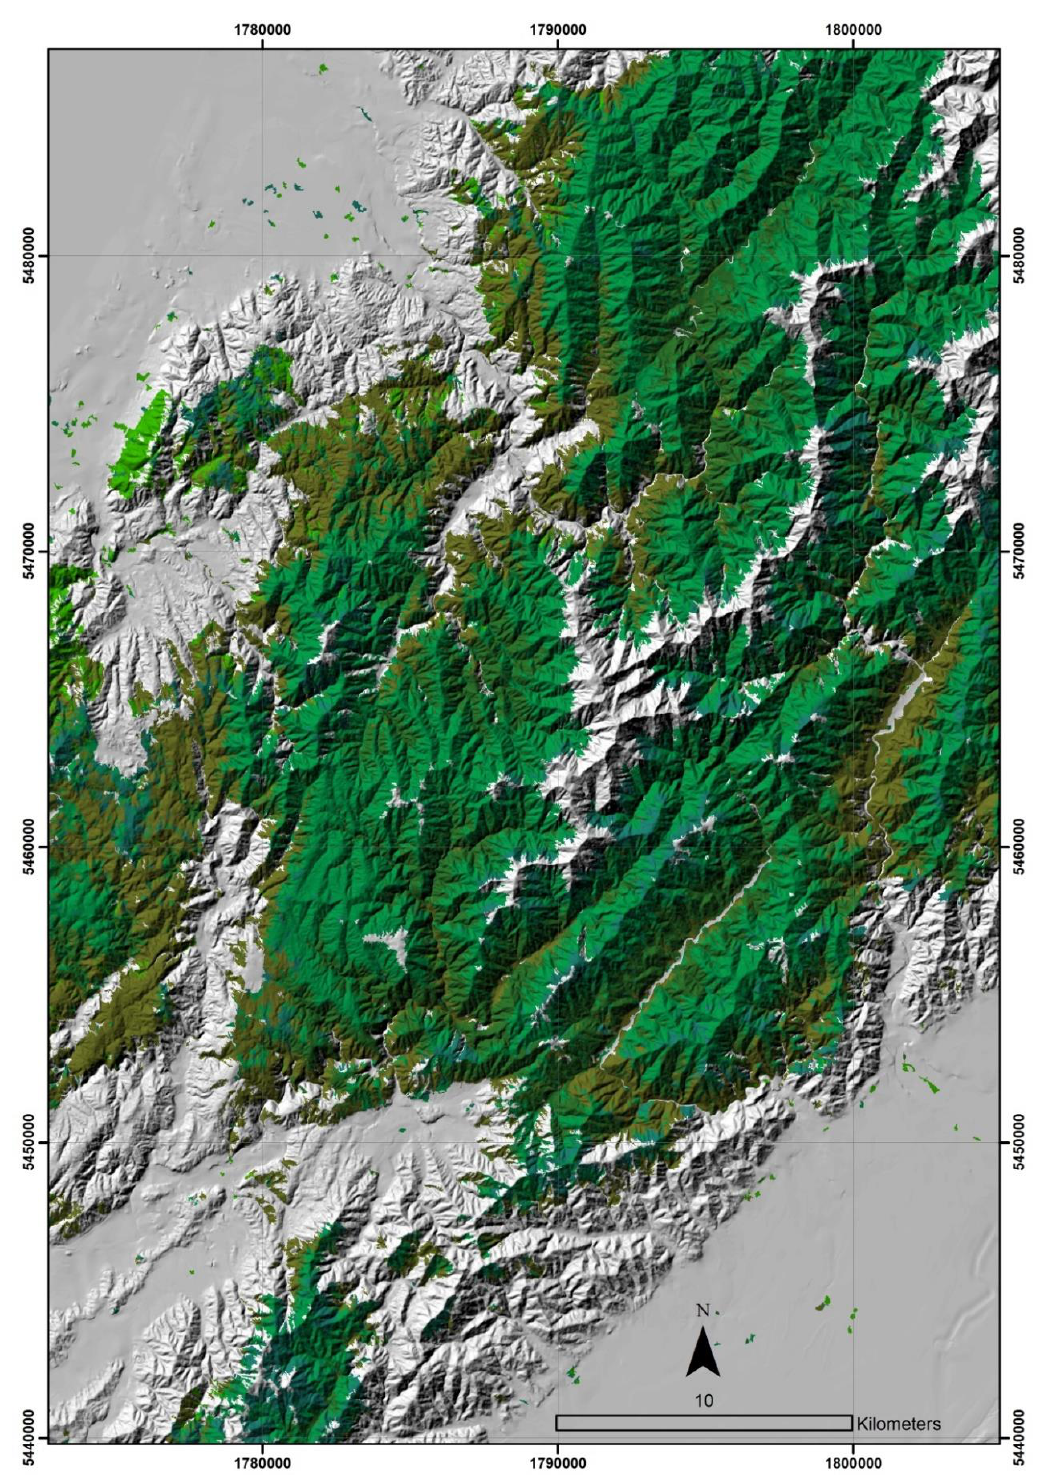
Figure 2. Map of forest physiognomic types following support vector machine (SVM) classification of spectral and structural information from Sentinel-1 and 2, PALSAR (Phased Array L-band Synthetic Aperture Radar) and Light Detection and Ranging (LiDAR) in transect across the Tararua ranges. Map grid is the New Zealand Transverse Mercator. Broadleaved-podocarp (olive); Beech-broadleaved-podocarp (dark green); Beech-broadleaved (green-blue); Broadleaved (lime); Beech (blue).